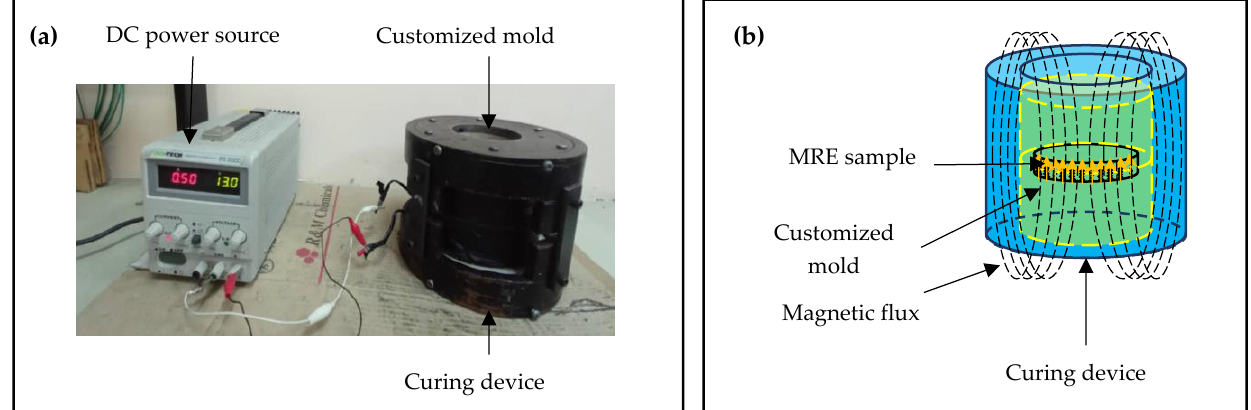
Figure 1. Optical images of anisotropic silicone-based MRE curing process: ( a ) real magnetic setup and ( b ) illustration of the magnetic flux inside the curing device.